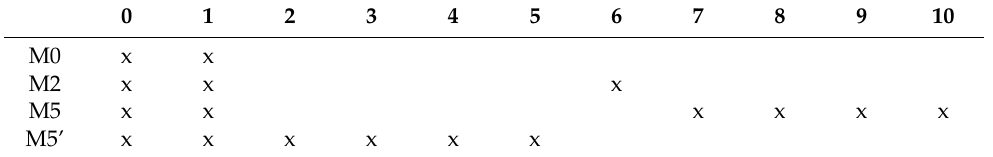
Table 3. 1 -BPS brane intersection underlying the AdS 3 / Z k × S 3 solutions in M-theory. x 1 is the 8 direction of propagation of the M0-branes, ( x 2 , . . . , x 5 ) span the CY 2 , x 6 is the direction along the ρ -interval and ( x 7 , x 8 , x 9 , x 10 ) are the transverse directions on which the SO(4) R-symmetry is